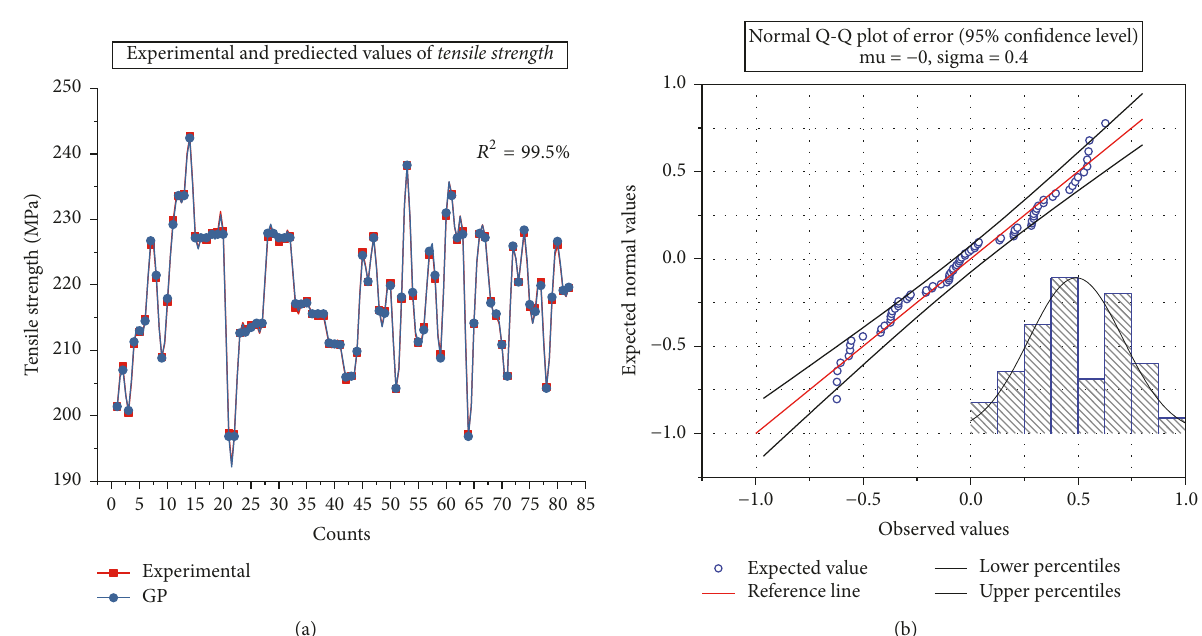
Figure 1: (a) Comparison between experimental and predicted values of tensile strength and (b) normal Q-Q plot of error between experimental and GP